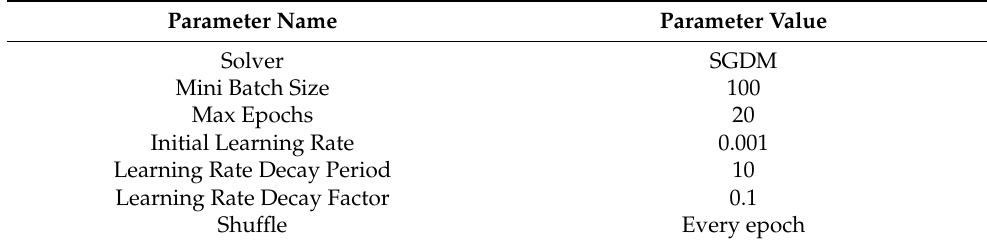
Table 2. Main training parameter settings for